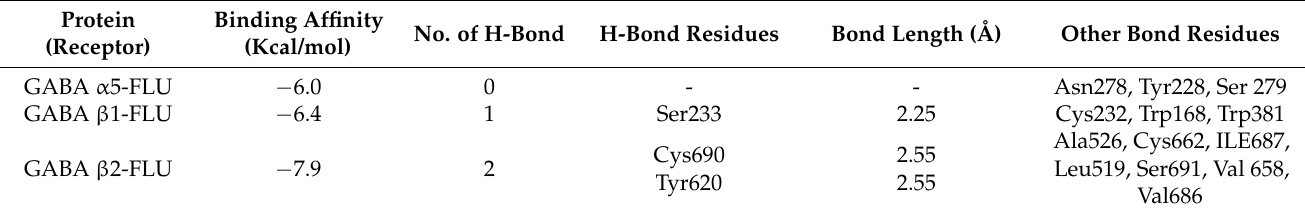
Table 7. The best three results of molecular docking study of flumazenil (FLU) with GABA recep- tor subunits.